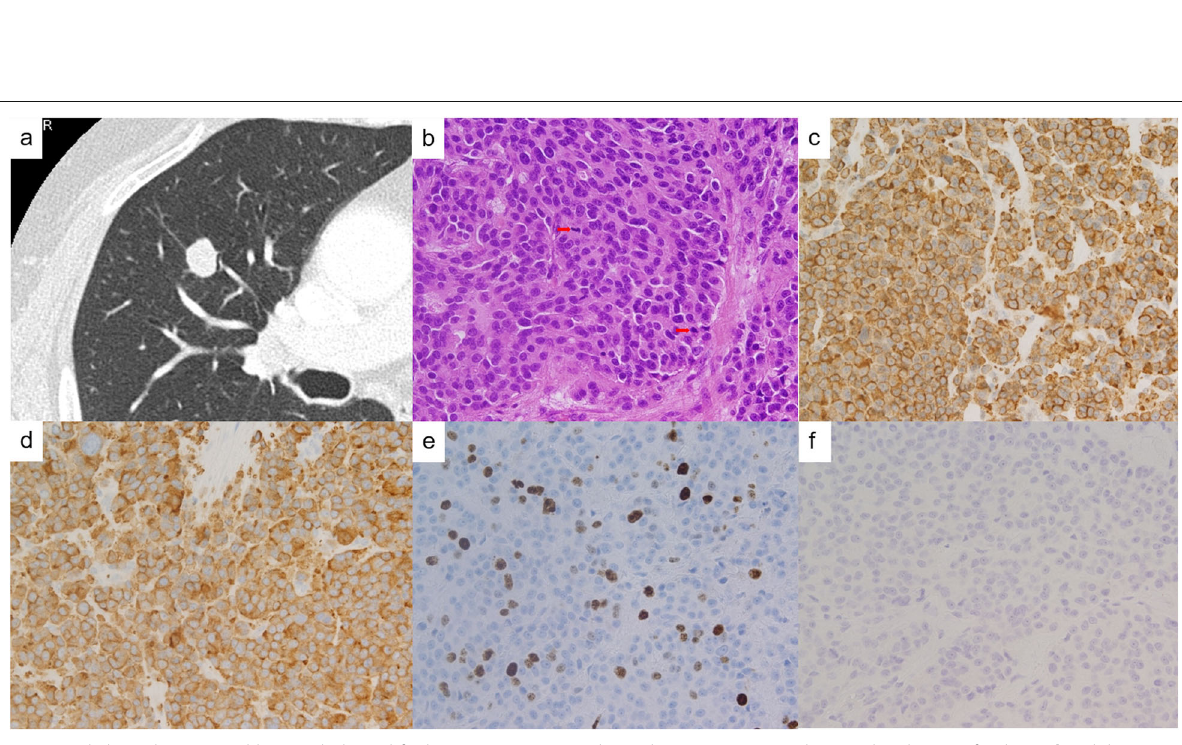
Fig. 2 Radiological image and histopathological findings in case 2. a CT showed a 1.4 cm mass in the peripheral zone of right S3. b Solid proliferation of round-to-ovoid tumor cells were seen and two mitotic figures (red arrows) can be seen in this hematoxylin and eosin staining micrograph (× 40). c Tumor cells found positive for chromogranin A. d Tumor cells found positive for synaptophysin. e 27% of tumor cells were positive for Ki67. f Tumor cells found absent of SSTR-2 immunoreactivity (score 0)